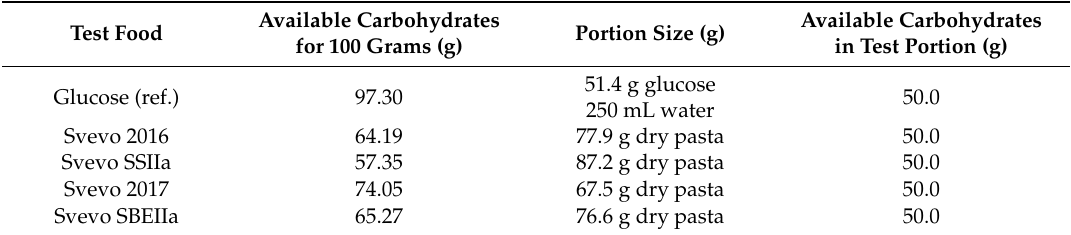
Table 6. The weight and carbohydrate contents of the test portions of the reference food (glucose) and the HA and control pasta products, calculated using manufacture’s data.